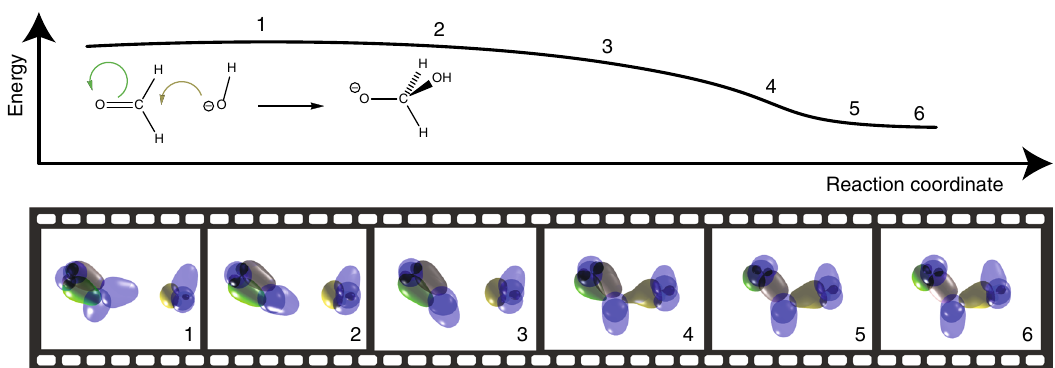
Fig. 4 The nucleophilic addition of hydroxide anion to a carbonyl group. Both electron spins follow the same path